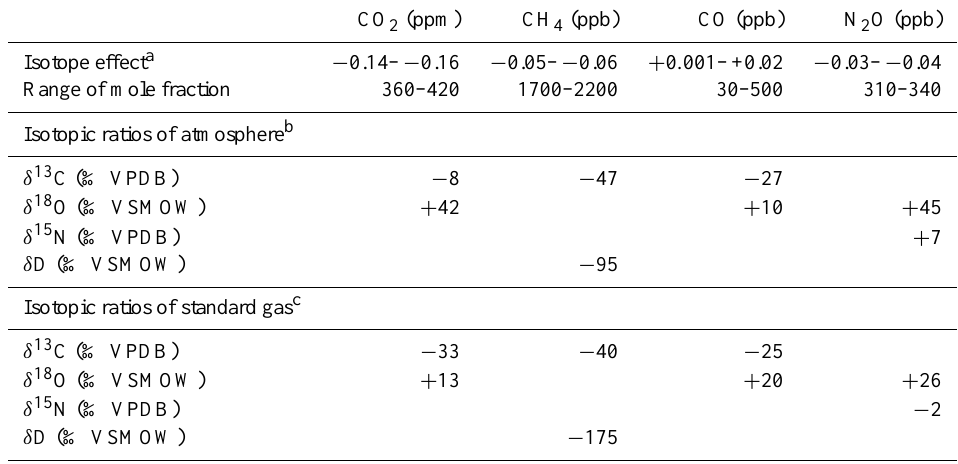
Table 2. Estimated isotope effects for CO 2 , CH 4 , CO and N 2 O measured by two laser-based analyzers of WS-CRDS and